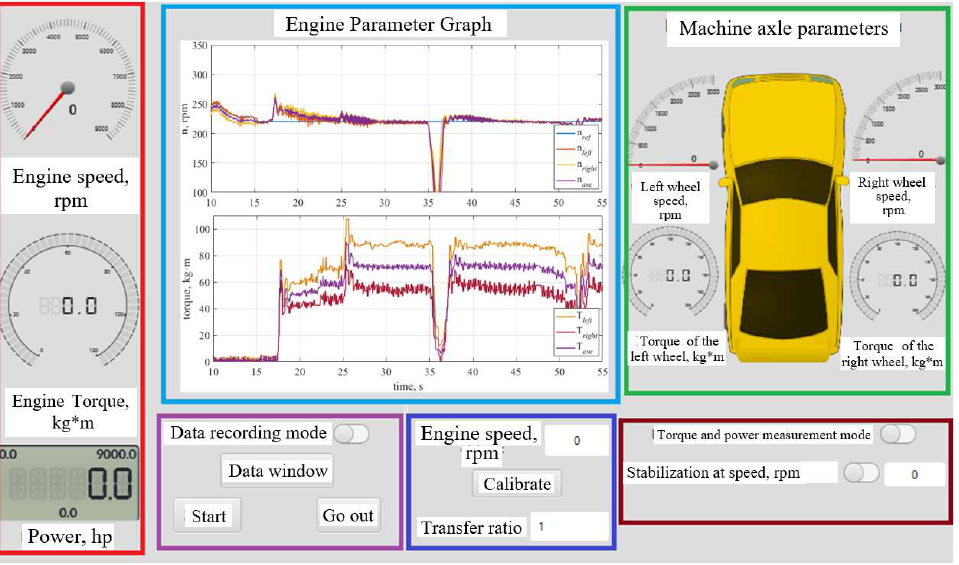
Figure 7. PC APP interface.